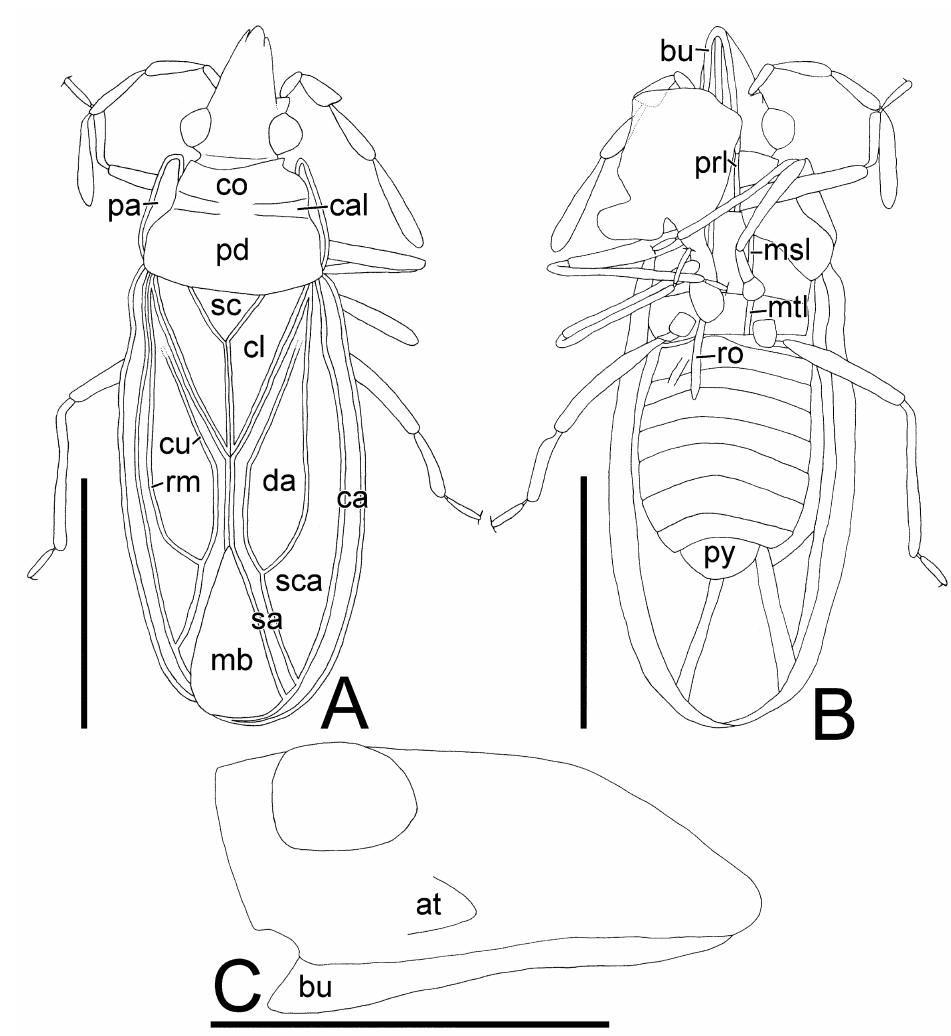
Figure 3. Line drawings of Burmavianaida anomalocapitata gen. et sp. nov. from mid-Cretaceous Kachin amber (holotype, AMNH Bu-SY29): general habitus, dorsal and ventral views ( A , B ); head, lateral view ( C ). Abbreviations: at, antenniferous tubercle; bu, buccula; ca, costal area; cal, calli; cl, clavus; co, collar; cu, Cu (cubital) vein; da, discoidal area; hl, hypocostal lamina; mb, membrane; msl, mesosternal lamina; mtl, metasternal lamina; pa, paranotum; pd, pronotal disc; prl, prosternal lamina; rm, R+M (radiomedial) vein; ro, rostrum; py, pygophore; sa, sutural area; sc, scutellum; sca, subcostal area. Ventral surface partly obscured by impurity. Scale bars: A, B, 0.5 mm; C, 0.2 mm. Pronotum (Figures 2A and 3A) flat; lateral margin with paranotum throughout its length. Pronotal disc coarsely punctate. Hood absent. Collar coarsely punctate; anterior margin nearly straight. Pronotal carina absent. Calli smooth on surface.